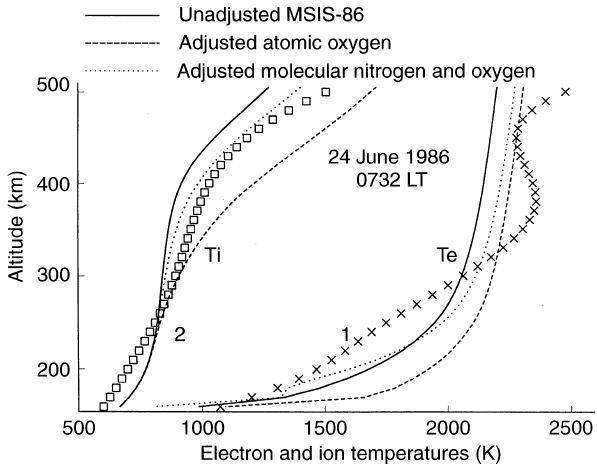
Fig. 4. Observed ( symbols ) and calculated ( lines ) electron ( curves 1 ) and ion ( curves 2 ) temperature at 0732 LT for 24 June 1986. The solid , dashed , and dotted lines are the same as for